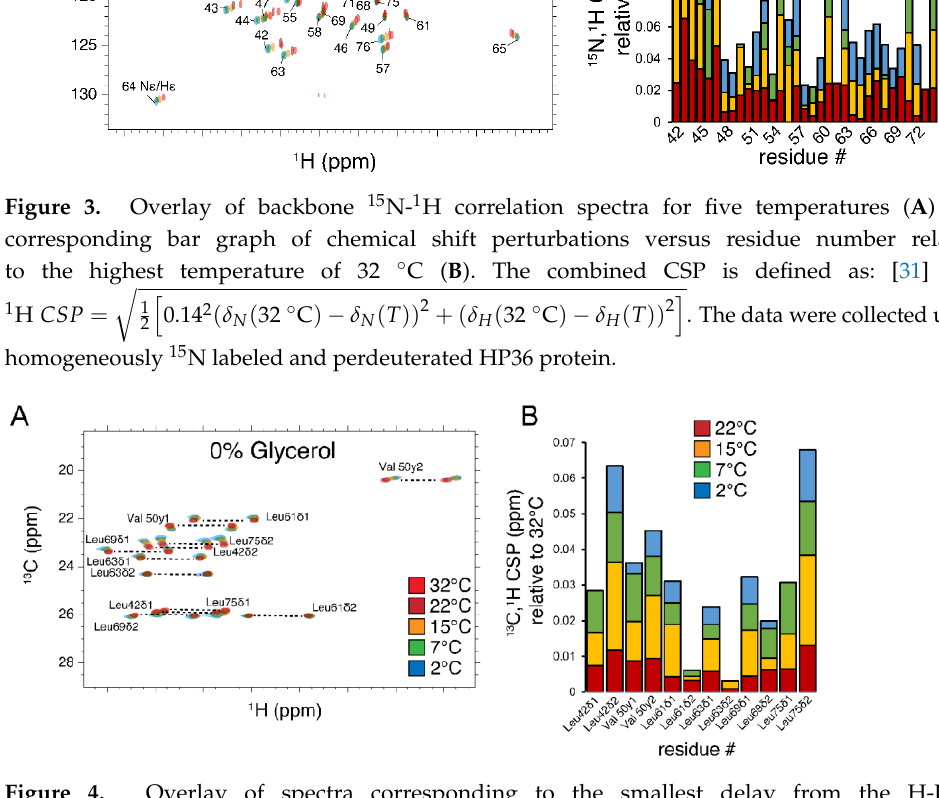
Figure 4. Overlay of spectra corresponding to the smallest delay from the H-H/C-H dipole-dipole cross-correlated interference experiment for five temperatures ( A ) and the corresponding bar graph of chemical shift perturbations versus residue identity relative to the highest temperature of 32 °C ( B ). The combined CSP is defined as 13 C, 1 H CSP = 0.3 2 ( δ C ( 32 ◦ C ) − δ C ( T )) 2 + ( δ H ( 32 ◦ C ) − δ H ( T )) 2 [31]. The data were collected using perdeuterated and LV-methyl protonated HP36